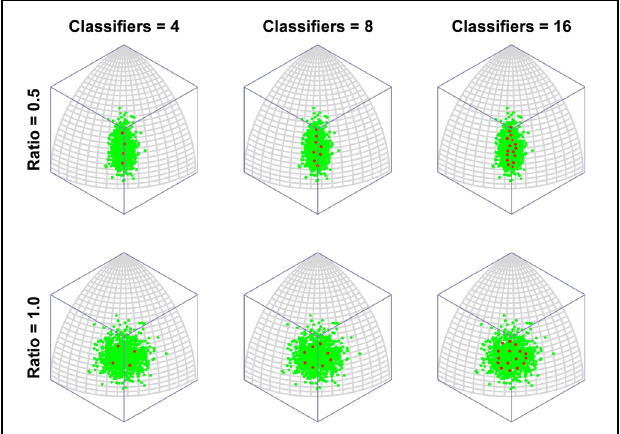
FIGURE 3 | The emergence of multidimensional (holistic) selectivity in neural classifiers. The figure is exactly comparable to Figure 2 except the axis of maximum variation is switched from longitude to latitude to demonstrate that the effect is not somehow being distorted or exaggerated by plotting on the surface or a spherical under orthogonal